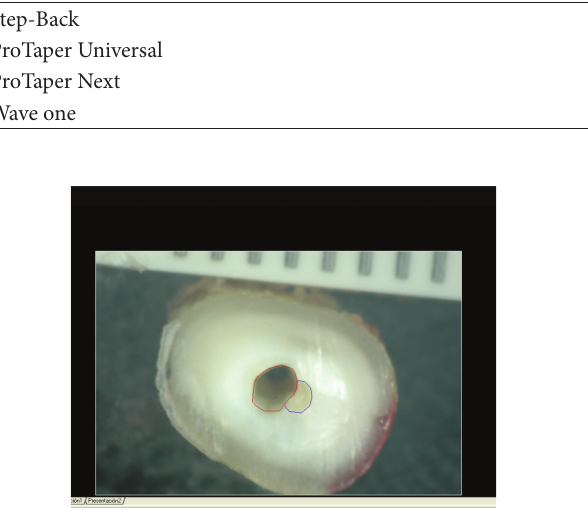
Figure 3: AutoCAD imagery showing the prepared canal (in red) and the unprepared canal (in